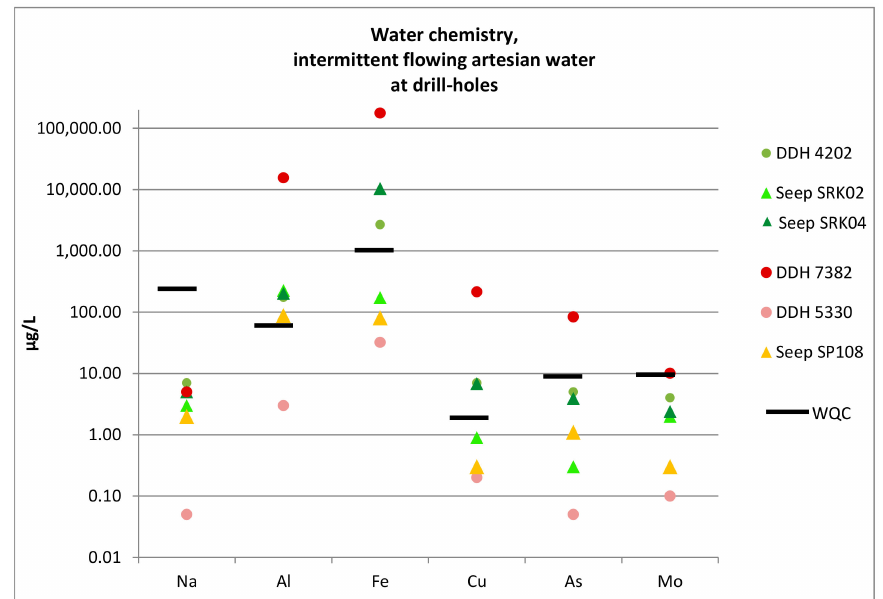
Figure 5. Wetland water chemistry at drill sites. Select chemistry of wetland water surrounding drill-holes with potential artesian flow, and of the nearest seeps. Only commonly elevated analytes are shown. Black bars—WQC for aquatic life [23]. For hardness-dependent metals a hardness of 25 mg / L was applied. Seep data was collected by PLP